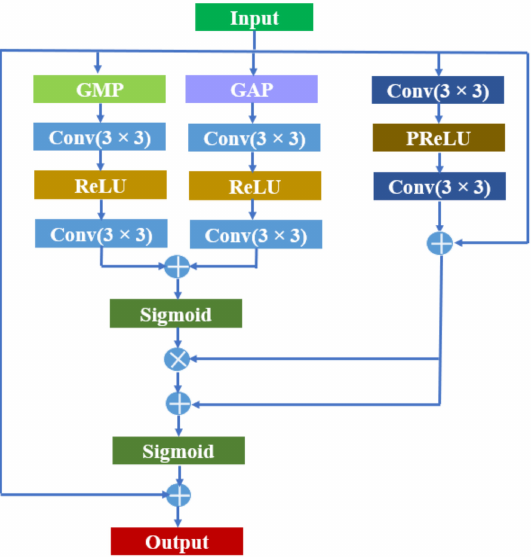
Figure 5. Residual dual channel attention